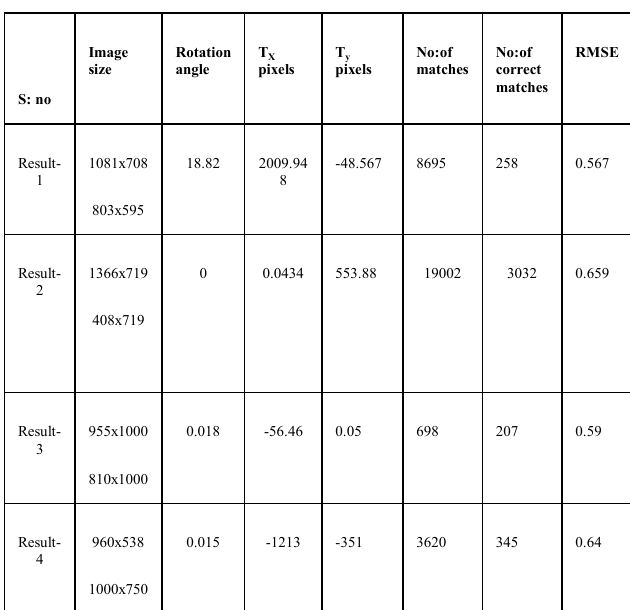
Figure 9. Result-3